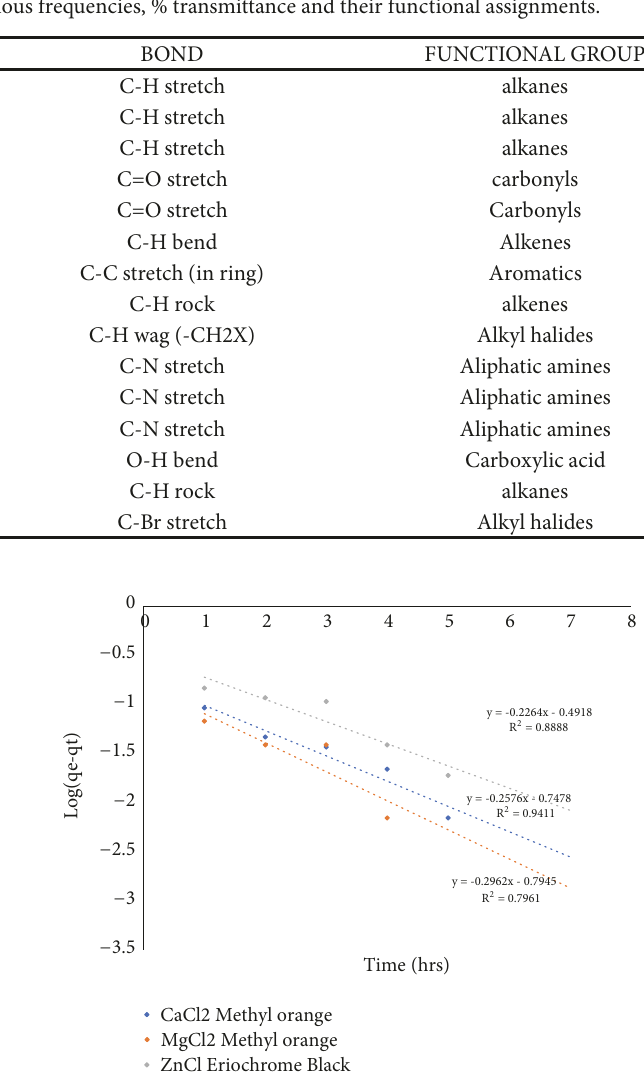
Figure 2: Percentage reduction of dyes with time (hrs).